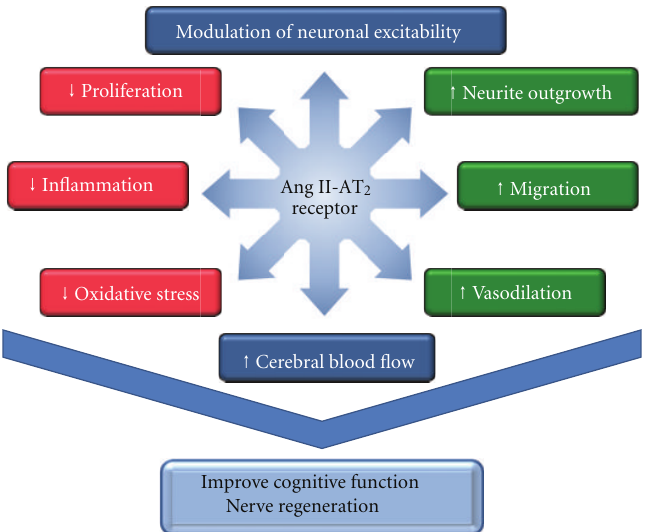
Figure 3: Summary of the known cellular e ff ects of the AT 2 receptor. Stimulation of the AT 2 receptor of angiotensin II results in the activation of several intracellular cascades, resulting in a decrease in proliferation and in growth-promoting e ff ects, as well as a decrease in inflammatory cytokines and in reactive oxygen species, hence decreasing oxidative stress. On the other hand, such activation increases neuronal excitability, by acting on K + and Ca 2+ channel activity, and increases neurite outgrowth and migration of neurons, favoring neuronal plasticity. Stimulation of the AT 2 receptor is also known for its e ff ect on vasodilation, thus increasing cerebral blood flow, and to increase glucose uptake, which improves insulin sensitivity. These cellular events in turn decrease or increase important physiological functions, which in general have reached a significant degree of consensus. Together, the AT 2 receptor may appear as a gatekeeper of cellular and tissue homeostasis. Indeed, most current studies suggest that AT 2 receptor activation may have a protective role in various pathological